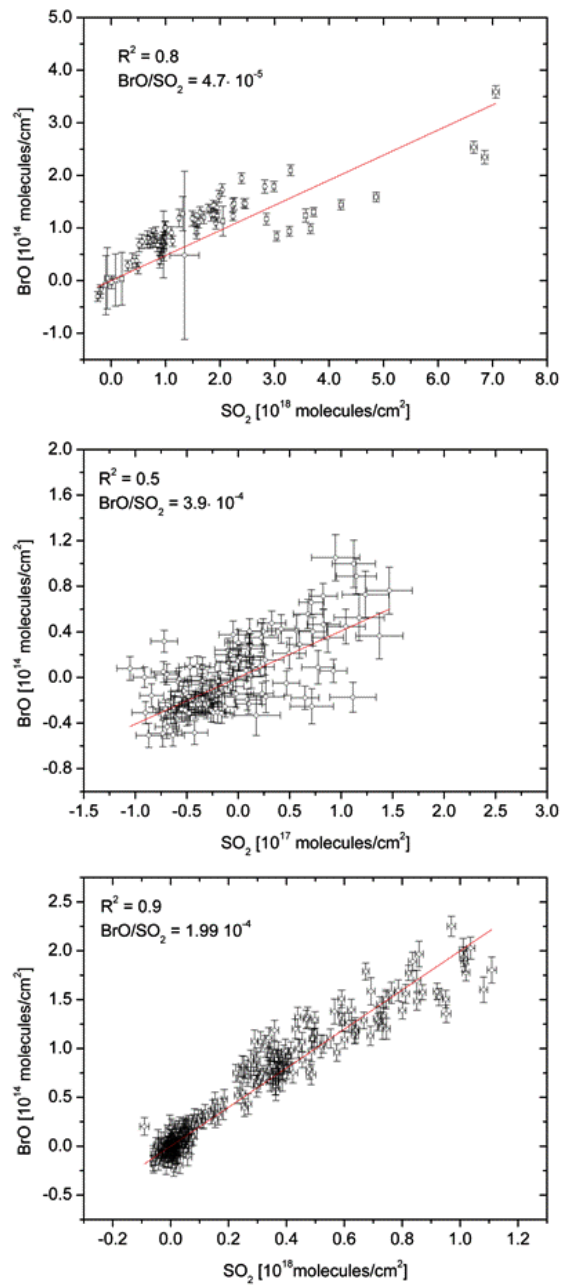
Fig. 2c. Examples of the BrO-SO 2 scatter plots: the scatter plot of the smallest BrO/SO 2 ratio, the scatter plot of the maximal BrO/SO 2 ratio and an example for a medium BrO/SO 2 scatter plot are shown, respectively.